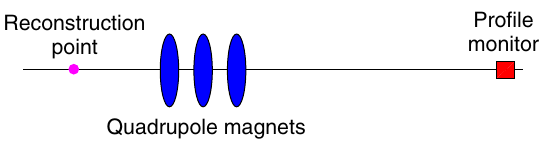
FIG. 1. Sketch of the measurement setup (not to